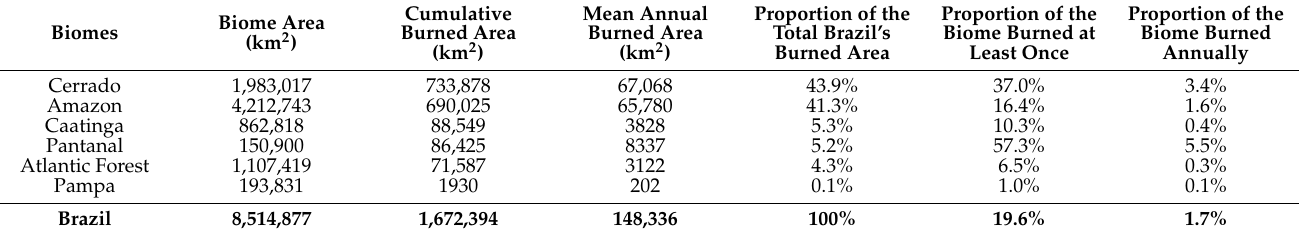
Figure 7. ( A ) Spatial distribution of the total area burned between 1985 and 2020 in Brazil; ( B ) Cumulative burned area between 1985 and 2020; and ( C ) Annual area burned from 1985 to 2020. Table 1. Cumulative burned area, mean annual burned area, proportion of the total burned area, proportion of the biome burned at least once, and proportion of the biome burned annually for the period of 1985 to 2020.